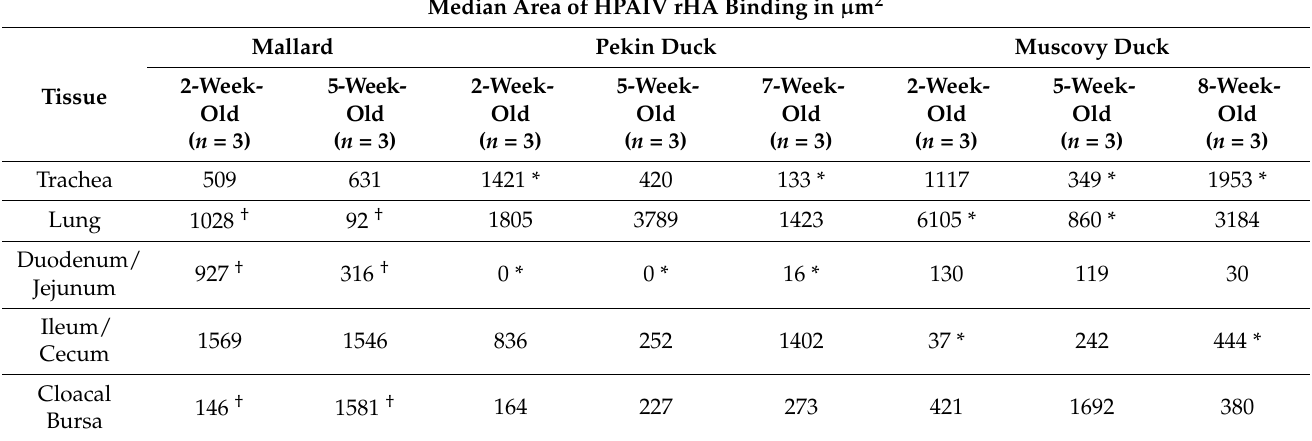
Table 1. Median area of binding (MAB) in µ m 2 of HPAIV rHA binding in the trachea, lung, small intestine, large intestine, and cloacal bursa of Mallards, Pekin ducks, and Muscovy ducks of different age groups.